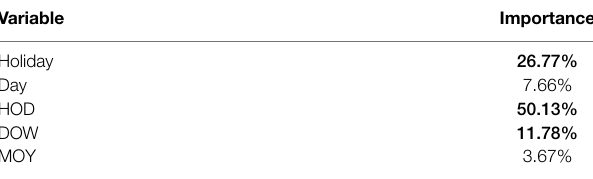
TABLE 5 | Importance of variable importance for future